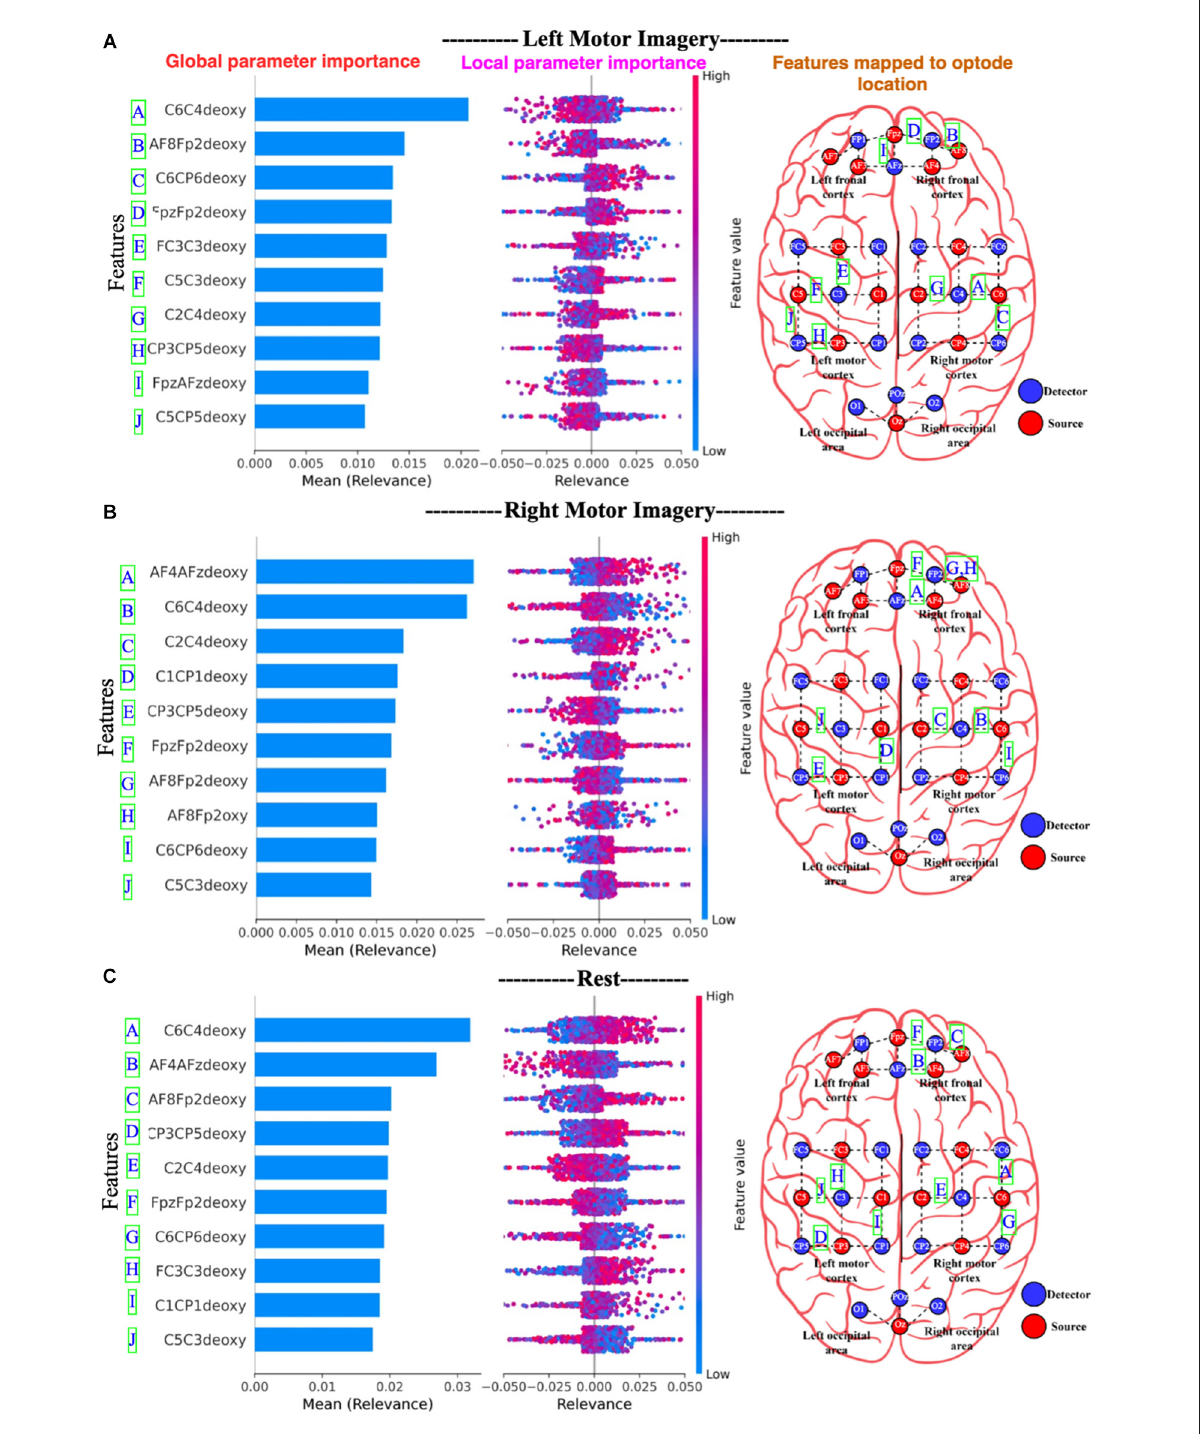
FIGURE16 Panel (A) represents Left active motor imagery; (B) represents Right active motor imagery and likewise, (C) represents Rest. The global features’ importance and local explanations summary are displayed in the results of the explanation module for dataset B. Note only 10 channels are plotted. On the right most part, the channels are mapped to the edges of the optode locations.